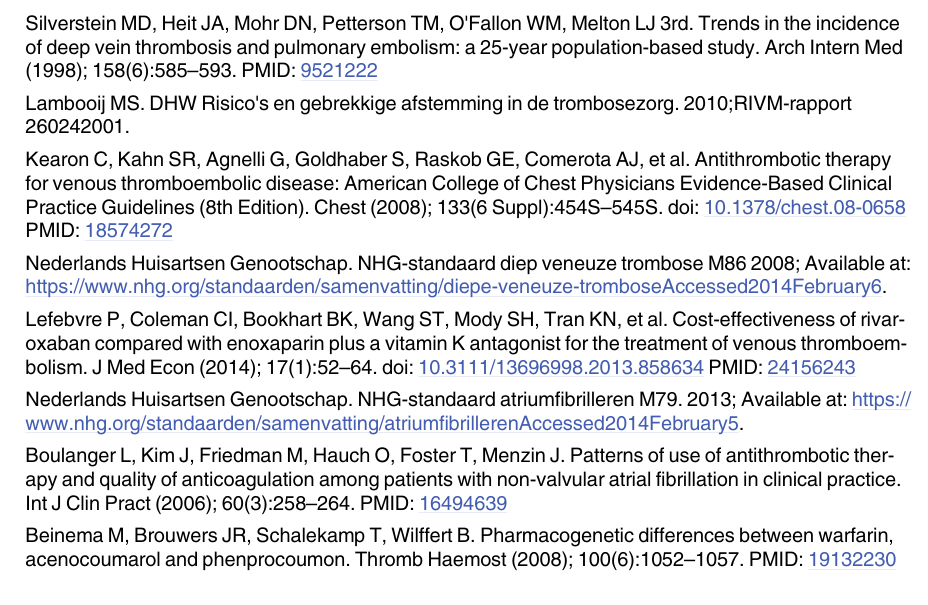
S2 Table. Utilities applied in the model. Utilities are determined for every health state. These utilities are not corrected for the norm population and treatment period and were assumed to follow a beta-distribution in the PSA. VTE: venous thromboembolism; DVT: deep venous